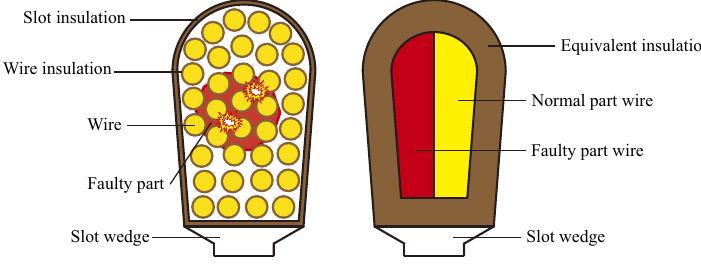
Figure 1. Equivalent model of a stator